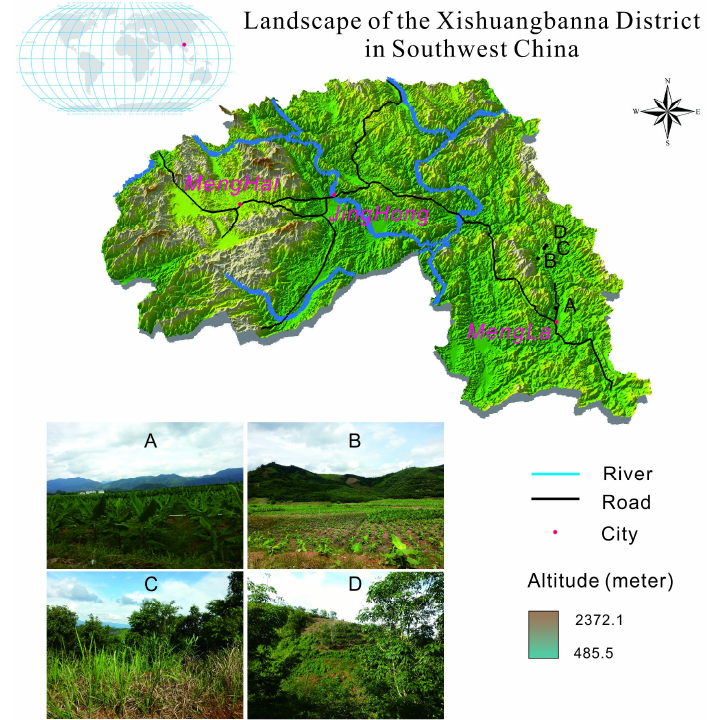
Figure 1. Landscape of the Xishuangbanna, China.